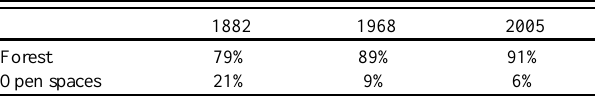
Table 3 . Proportion of forestland and open spaces in Bad Rippoldsau-Schapbach in the years 1882, 1968, and 2005 (% of the municipality’s total